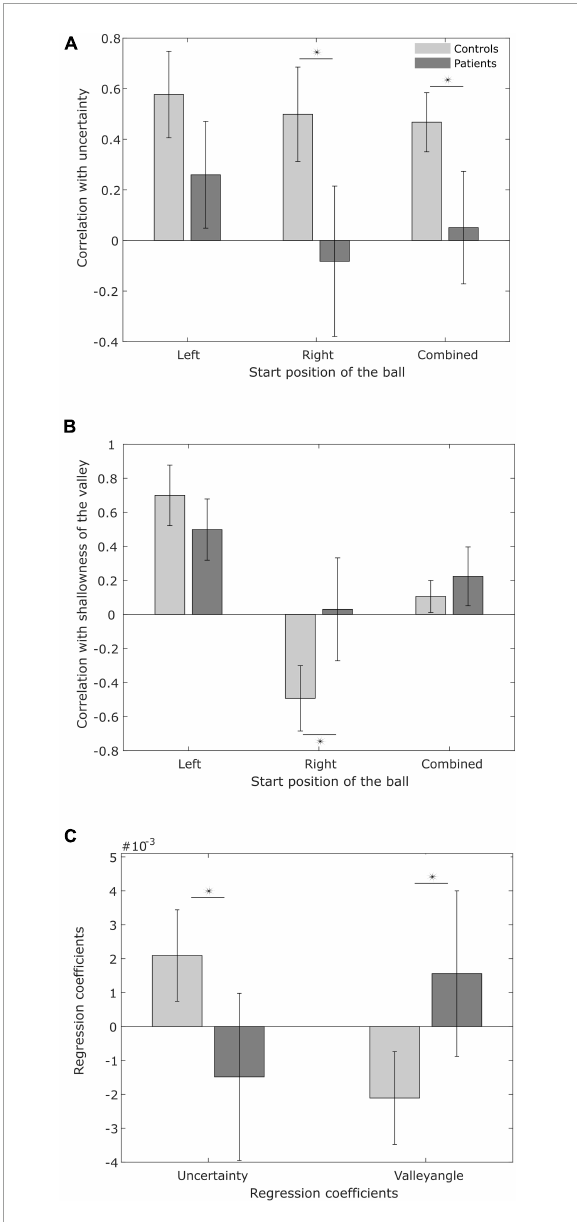
FIGURE7 Variability in switching time. (A) Pearson correlation between the variability in switching time and predicted minimal sensory-motor uncertainty, for patients and controls. (B) Pearson correlation between the variability in switching time and shallowness of the valley. (C) Regression coefficients for predicted minimal sensory-motor uncertainty and shallowness of the valley as explanatory variables for observed switching time